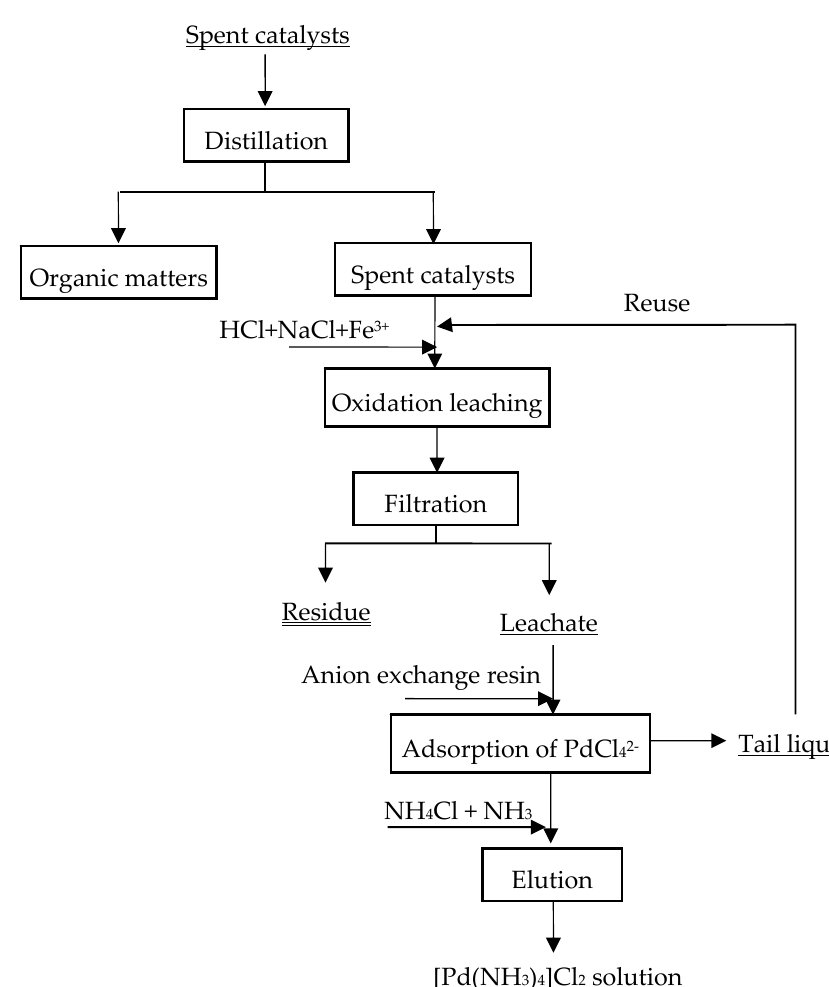
Figure 1. Flowsheet of leaching Pd from spent catalysts.